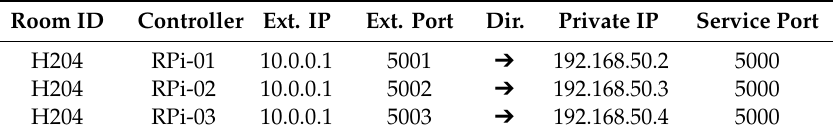
Table A3. Port redirection settings on the smart classroom NAT gateway. Room ID